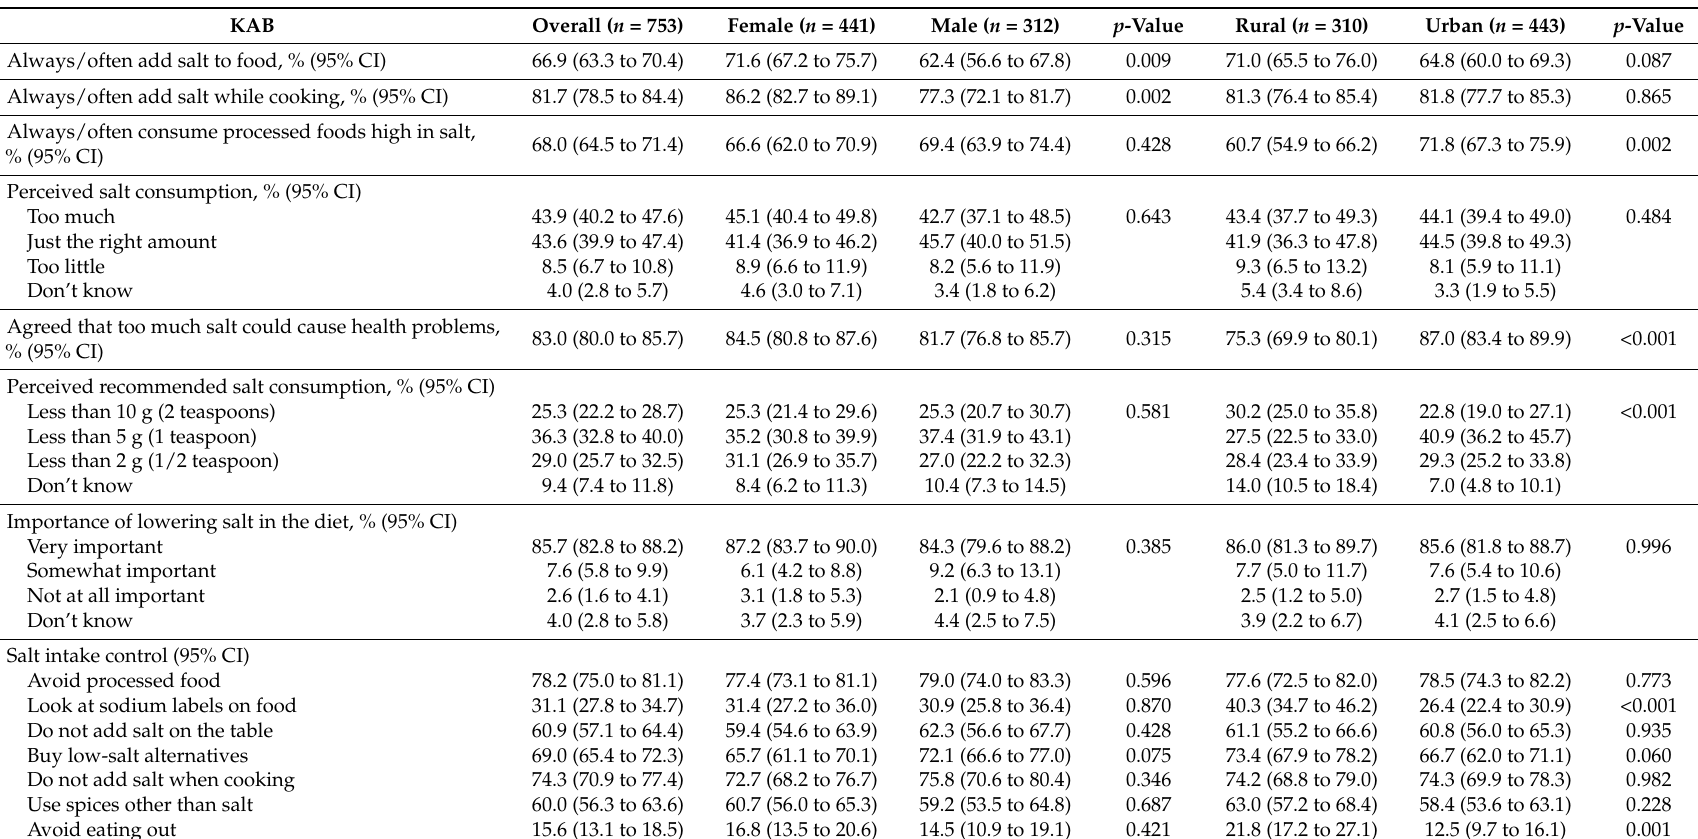
Table 2. Weighted knowledge, attitudes, and behaviors (KAB): Results overall and of subgroup analyses for sex and